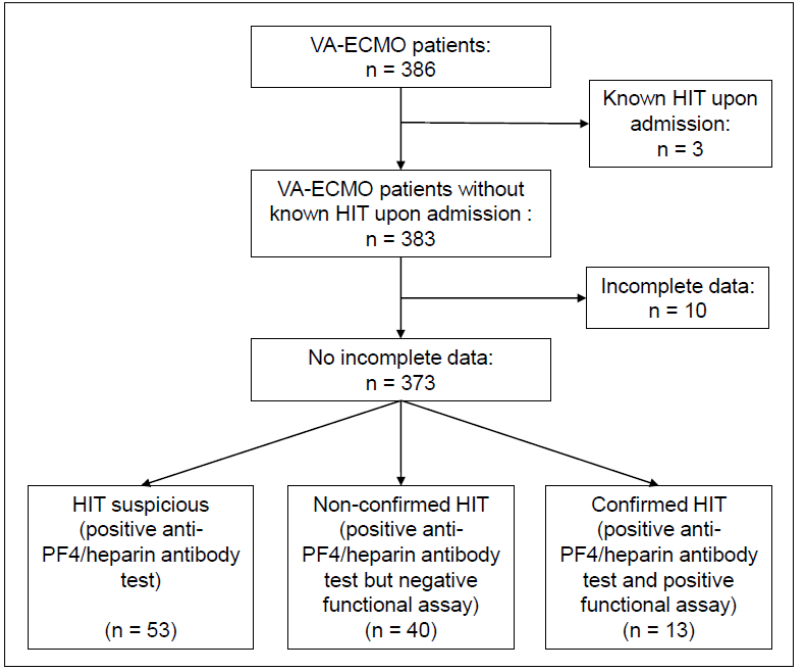
Figure 1. Flow diagram depicting patient selection. Table 1. Baseline characteristics and ICU treatment.